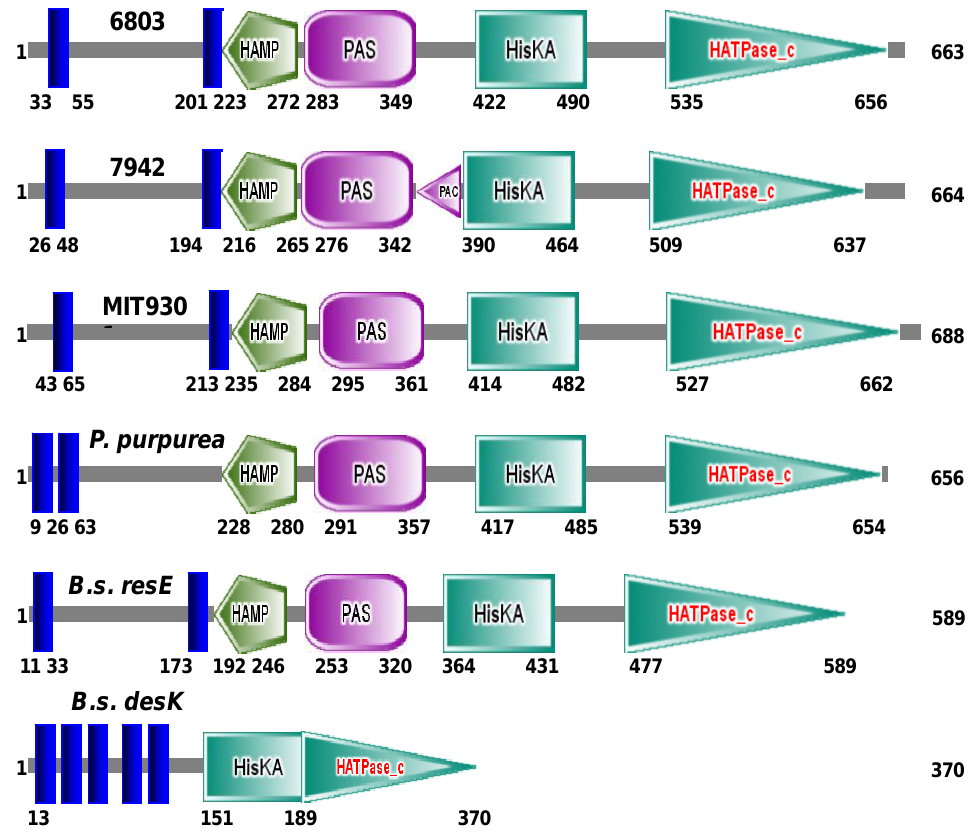
Figure 4 . Schematic representation of the monomeric Hik33 of Synechocystis sp. PCC 6803 and its homologs from other organisms: 7942– Synechococcus elongatus PCC7942; MIT9301– Prochlorococcus strain MIT 9301; P. purpurea – Porphyra purpurea ; B.s. – Bacillus subtilis . Numbers along the polypeptide sequences represent the corresponding numbers of amino acids starting from the first methionine. HAMP, PAS, PAC, HisKA, HATPase_c–the characteristic domains found by SMART software (http://smart.embl-heidelberg.de/). Hepcidin antimicrobial peptide (HAMP), HAMP-linker domains; LZ, leucine zipper domains; PER-ARNT-SIM (PAS), PAS domains that contain the amino acid motifs Per, Arnt, Sim and phytochrome [36]; blue rods represent the transmembrane domains.